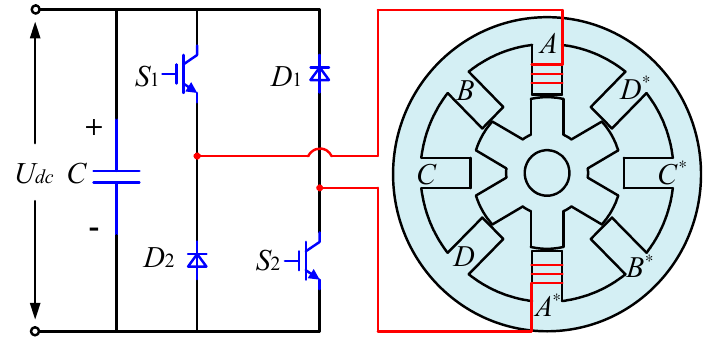
Figure 1. Schematic of switched reluctance motor (SRM).